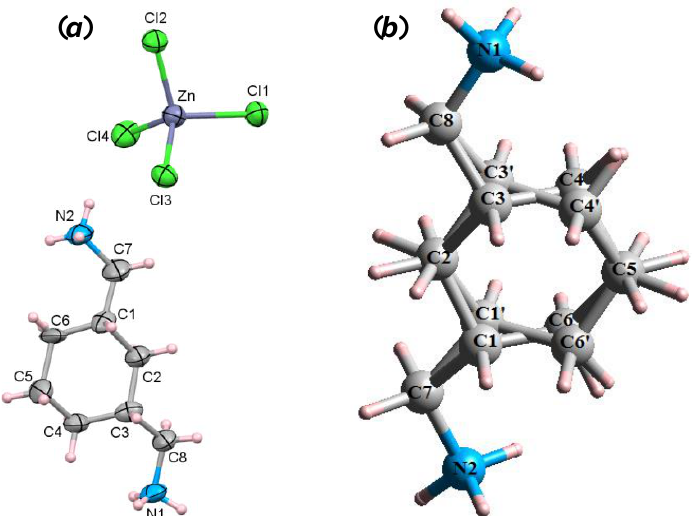
Figure 6. The asymmetric unit of the (CHBMAH 2 )ZnCl 4 4 (50% probability displacement ellipsoids) ( a ), the cyclohexane ring in 4 is disordered in two orientations ( b ). Examination of the C–C, C–N distances and C–C–C, C–C–N angles in the (CHBMAH 2 ) 2+